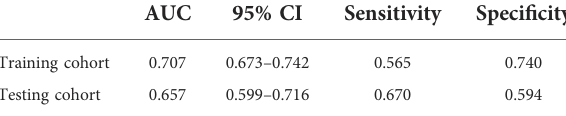
AUC, area under the receiver operating characteristic curve; CI, con fi dence